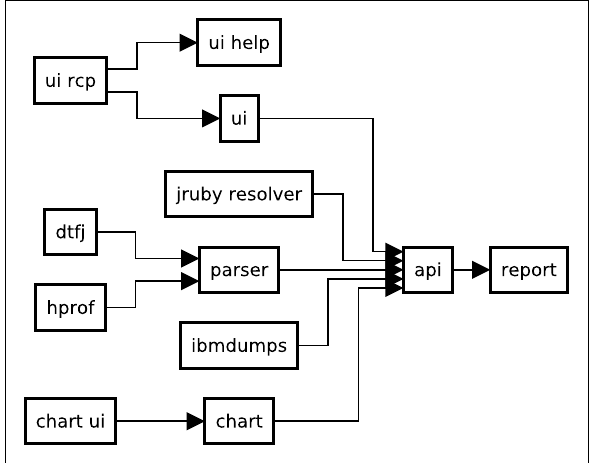
Figure 5: Dependency diagram of Eclipse